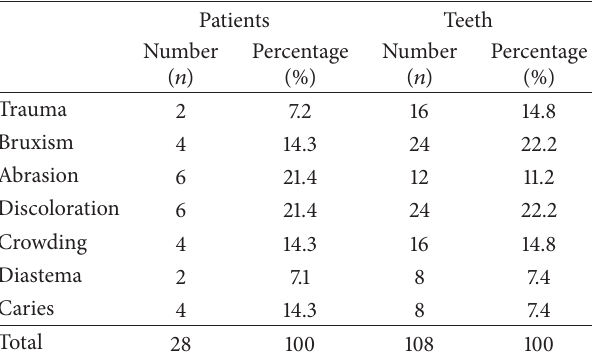
Figure 10: Final result: extraoral photography. Table 4: Preoperative parameters.